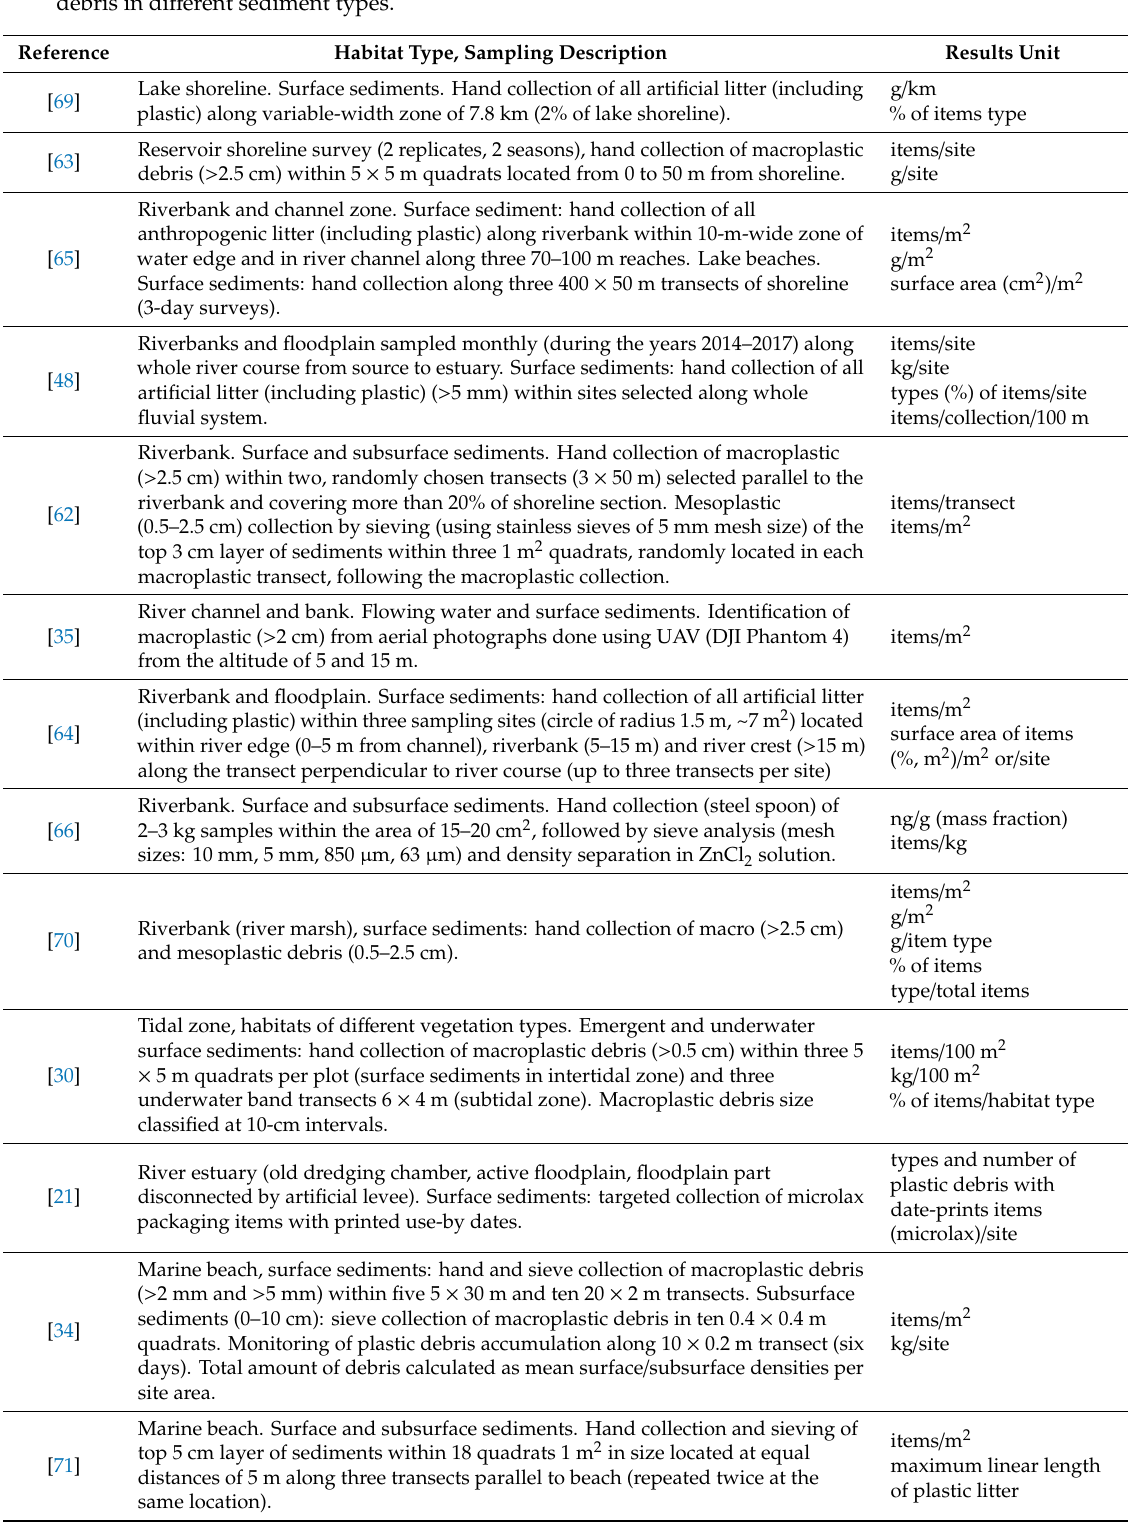
Table 1. Methods used in selected case studies for quantification of the abundance of macroplastic debris in di ff erent sediment